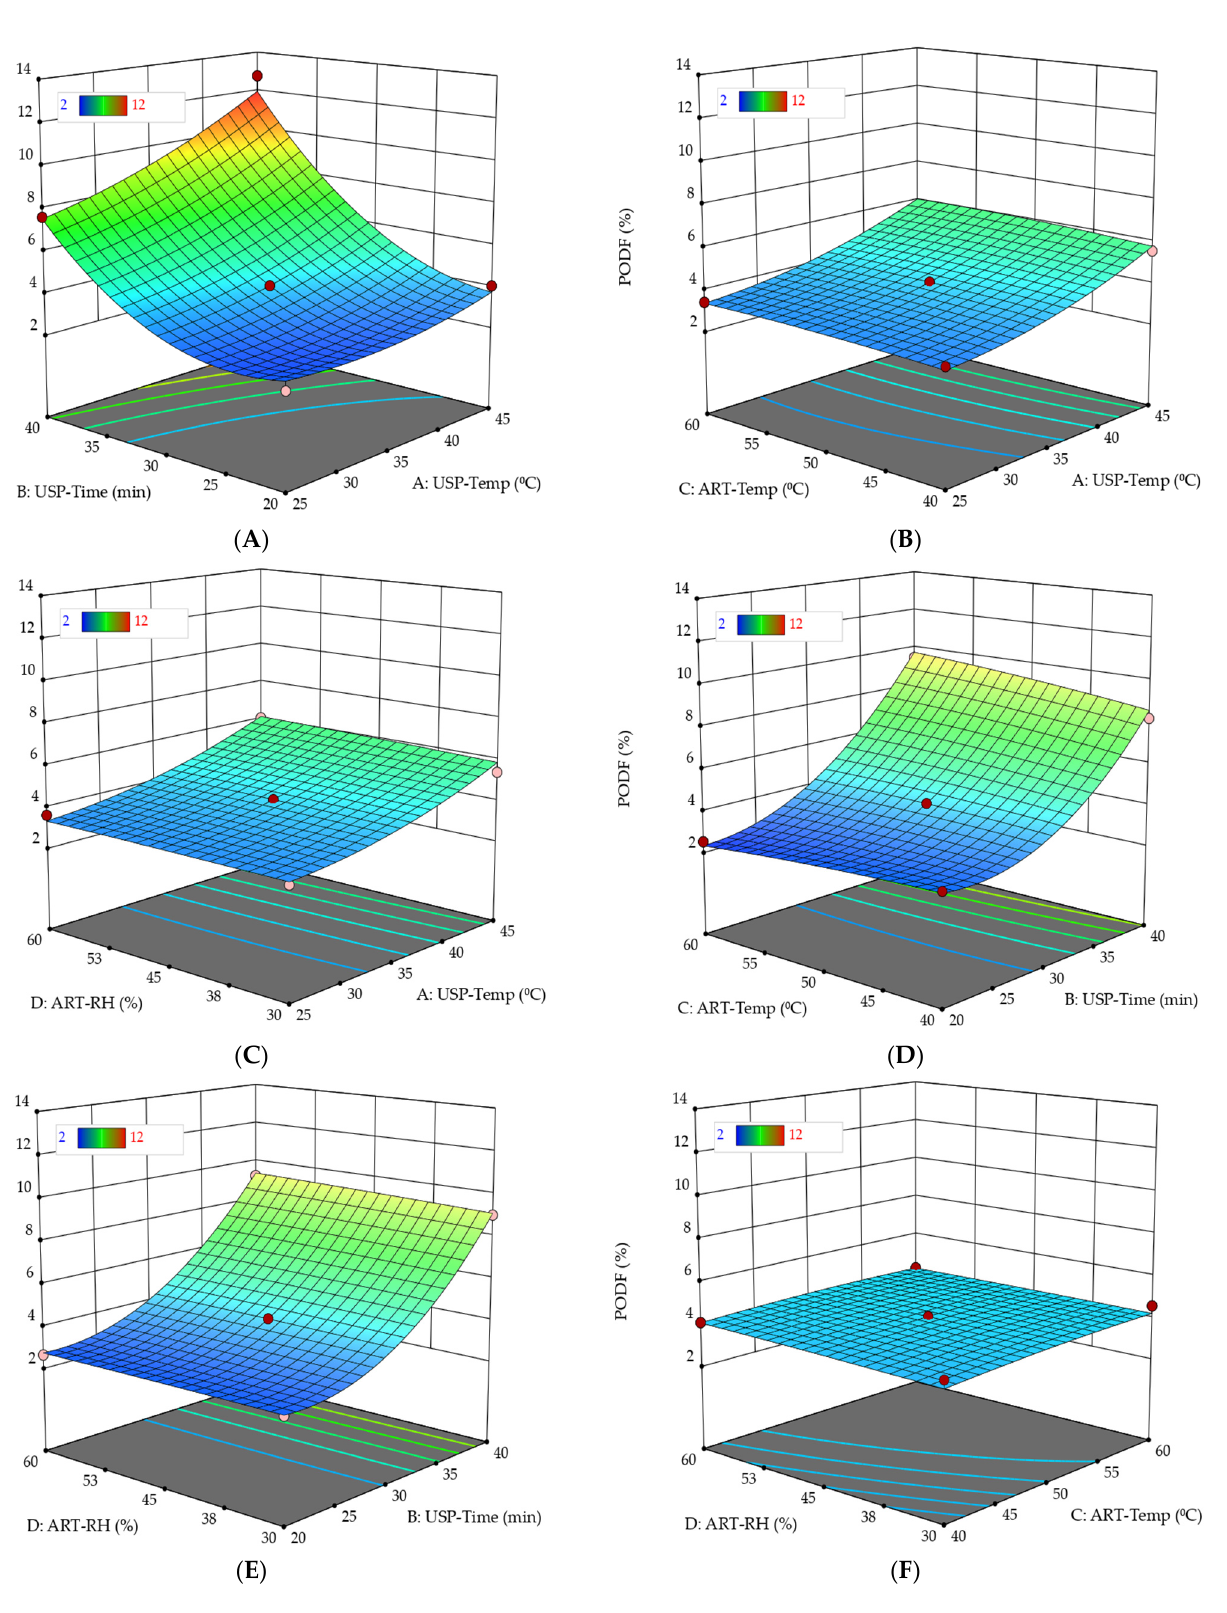
Figure 10. 3D response surface plots representing the effect of A: USP-Temp (ultrasound pretreatment time) and B: USP-Time (ultrasound pretreatment temperature) ( A ), A: USP-Temp and C: ART-Temp (ripening treatment temperature) ( B ), A: USP-Temp and D: ART-RH (ripening treatment RH) ( C ), B: USP-Time and C: ART-Temp ( D ), B: USP-Temp and D: ART-RH ( E ), C: ART-Temp and D: ART-RH ( F ) on the percentage of ripe fruits (PORF).